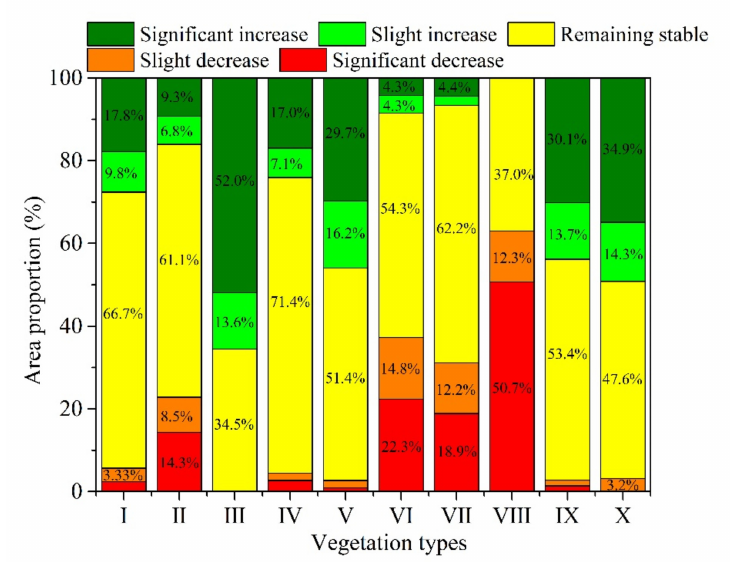
Figure 5. The proportion of the area that demonstrated each change trend on the Tibetan Plateau from 1985 to 2015. A significant increase or decrease indicates that the data passed the significance level test at 0.01. A slight increase or decrease indicates that the data passed the significance level test at 0.05. ( I ) Alpine steppe, ( II ) Alpine meadow, ( III ) Alpine desert, ( IV ) Temperate desert steppe, ( V ) Alpine sparse vegetation, ( VI ) Subalpine scrub, ( VII ) Needleleaf forest, ( VIII ) Broadleaf evergreen forest, ( IX ) Temperate desert, ( X ) Temperate steppe.